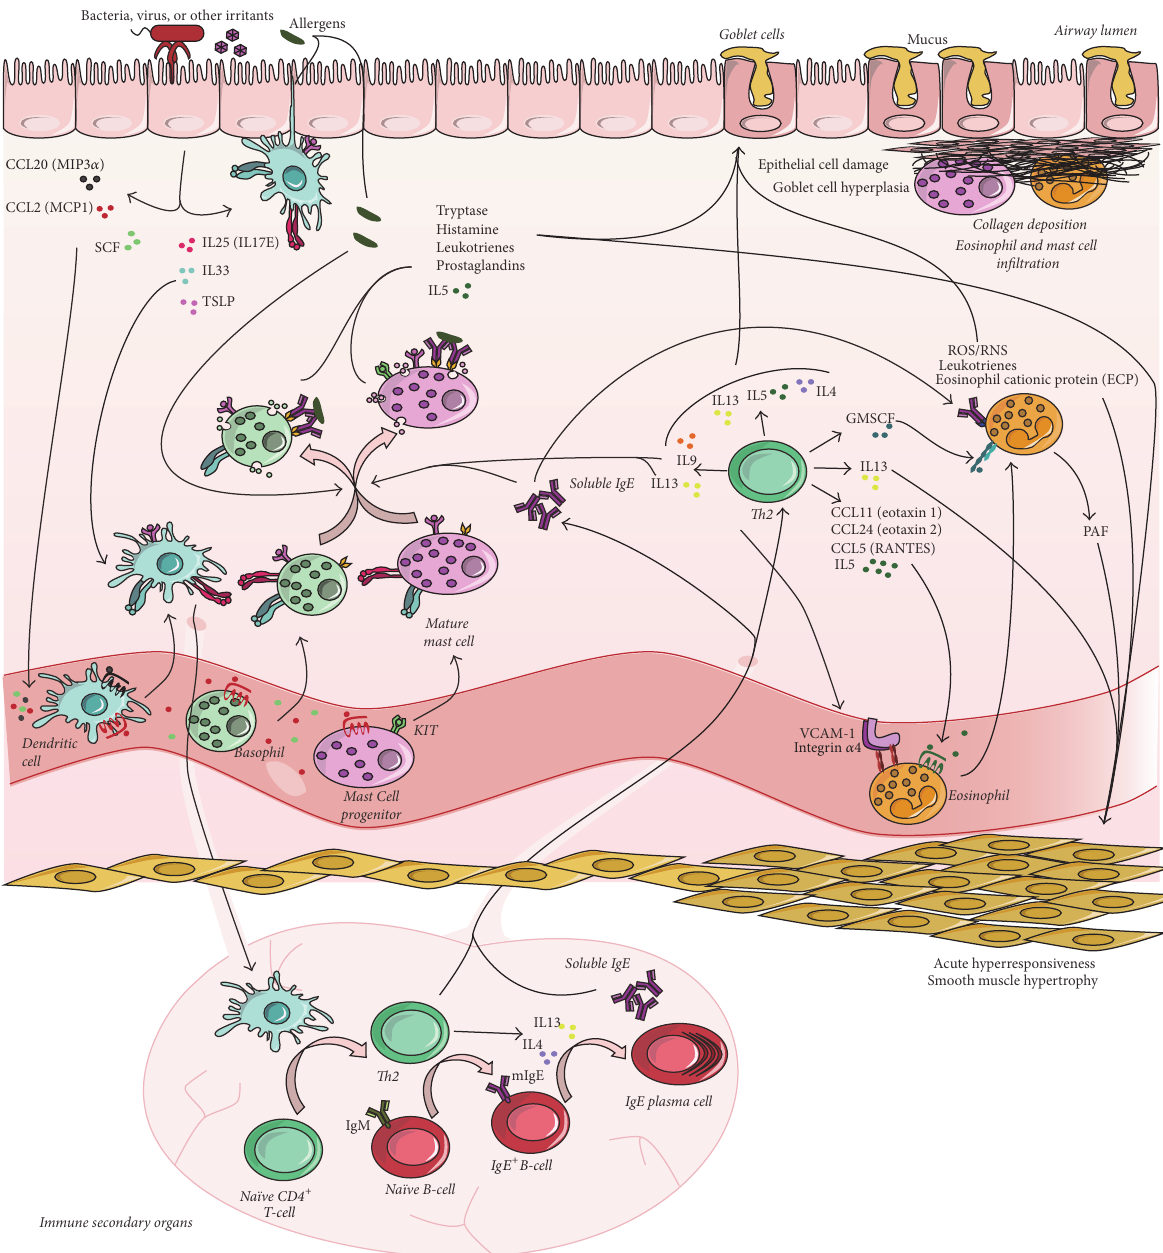
Figure 1: Pathophysiology of allergic asthma. Volatile allergens and/or other irritants can activate sentinel dendritic cells and/or epithelial cells in the airway epithelium that will also recruit and activate dendritic cells. The activation of dendritic cells will trigger Th2 responses, leading to the accumulation of soluble IgE as well as several cytokines. These cytokines will recruit mast cell progenitors, as well as basophils and eosinophils, which will be activated and secrete proinflammatory cytokines and other soluble factors such as histamine, tryptase, prostaglandins, and leukotrienes. As a consequence, there will be an increase in mucus production and bronchoconstriction (for mechanistic details,seetext).Ifthisactivationismaintained,theairwaywillsufferpersistentstructuralchangesthatwillcausechronicbronchoconstriction due to fibrosis in the subepithelium and smooth muscle hypertrophy. mIgE: membrane IgE; PAF: platelet-activating factor.